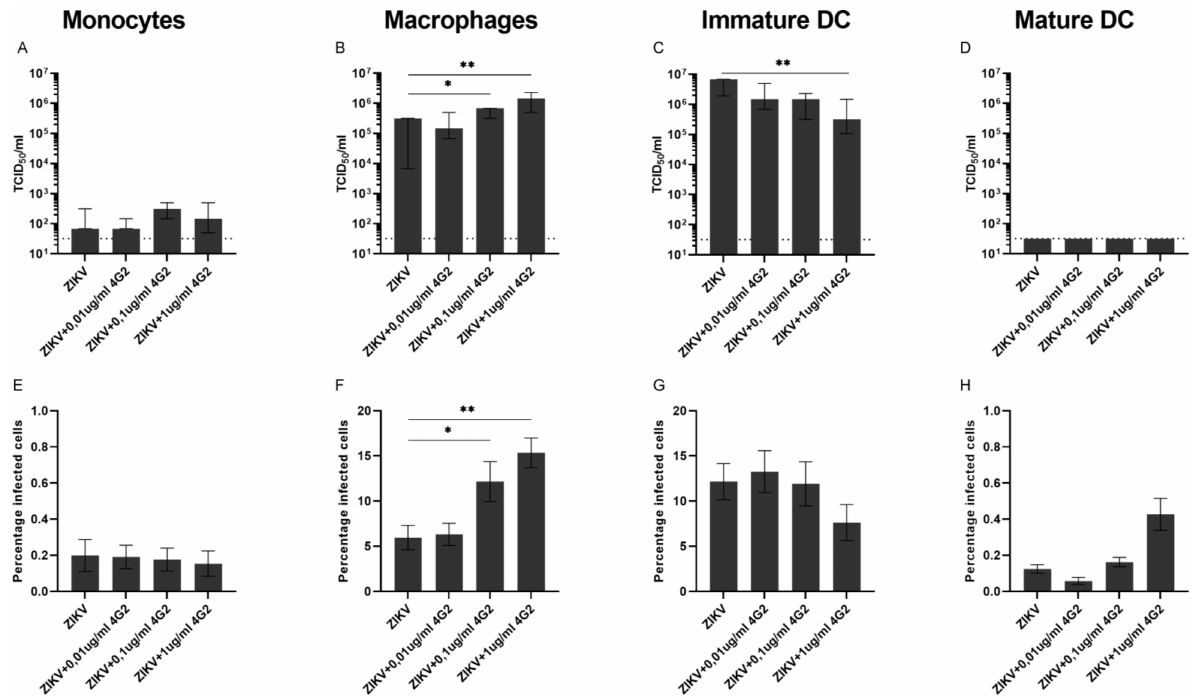
Figure 3. ADE of ZIKV infection in primary myeloid cells. Fc γ R-bearing human myeloid cells were infected for 48 h with ZIKV at an MOI of 0.5 with and without increasing concentrations of the pan-flavivirus humanized monoclonal antibody 4G2 (hu4G2). Viral titers in supernatants were determined with titration ( A – D ) and the percentage of infected cells was determined with flow cytometry ( E – H ). Bars represent median titer ± IQR ( A – D ) and mean a percentage of infected cells ± SEM ( E – H ). Statistical significance was determined with the Kruskal–Wallis test with